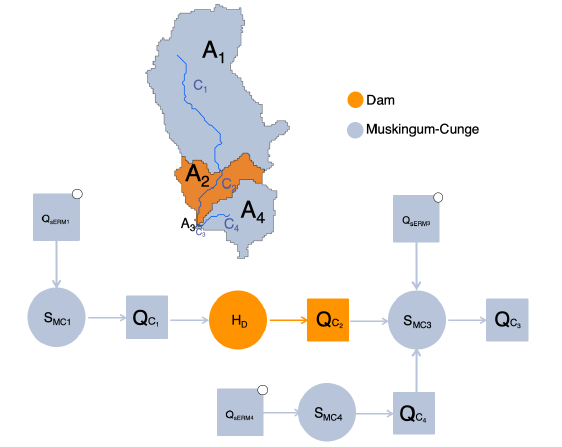
Figure 5. Representation of the dam reservoir connection with uphill and downhill